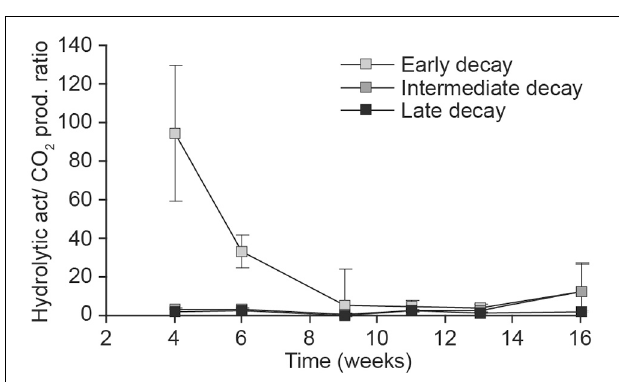
and late-decayed substrate (C). The dilution of fungal diversity is shown by symbols as undiluted fungal inoculum (squares), dilution 10 − 1 g inoculum/g substrate (circles), dilution 10 − 2 g inoculum/g substrate (triangles), and controls (diamonds).